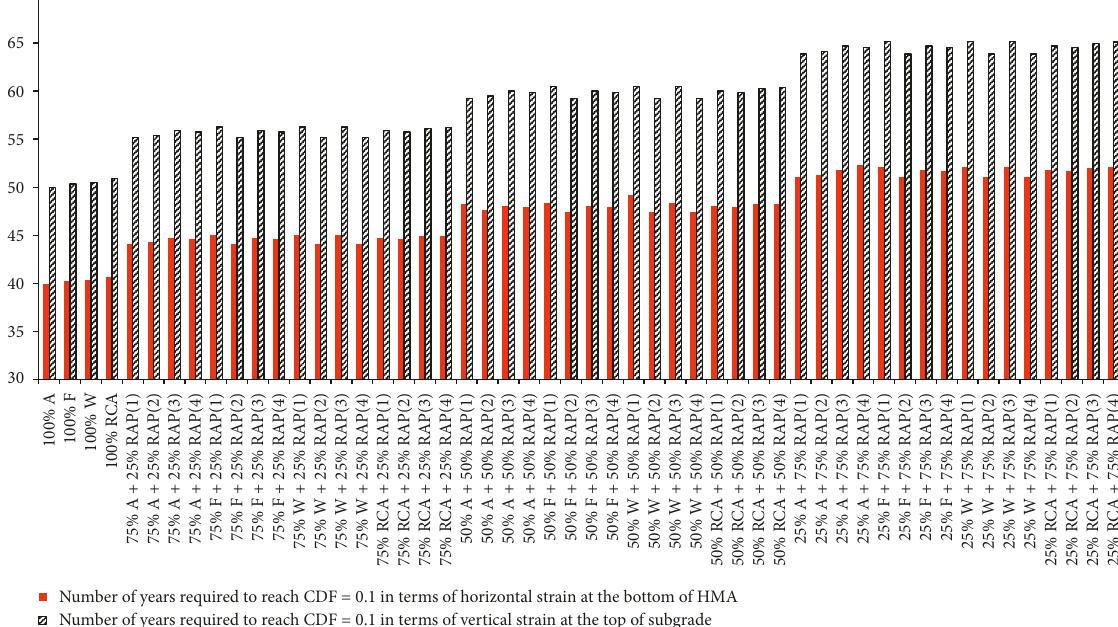
0.1 in terms of horizontal strain at the bottom of HMA and vertical strain at the top of (cid:30)